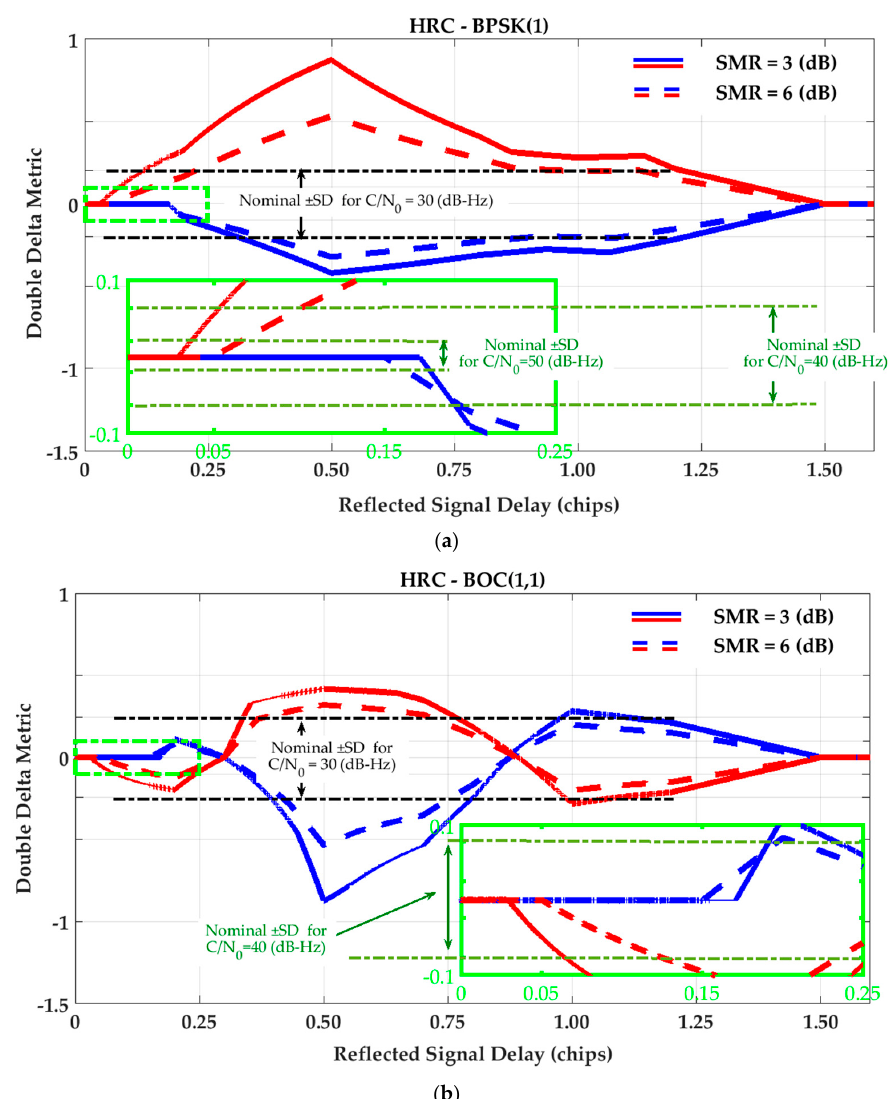
Figure 4. SQM variation envelopes of Double-Delta metric for ( a ) High Resolution Correlator (HRC) strategy and BPSK(1) signaling; ( b ) High Resolution Correlator (HRC) strategy and BOC(1,1) signaling.